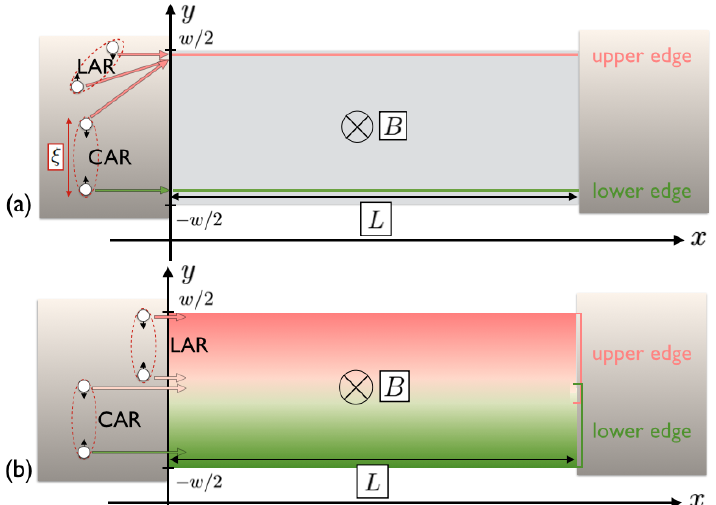
Figure 1. Panel ( a ) shows a two-dimensional topological insulator (2DTI) of length L and width w laterally tunnel-coupled to two superconducting electrodes (in grey). Then, a magnetic field B is applied perpendicularly to the junction. The pink and green line represent the edge states on the boundaries of the 2DTI which are not proximitized. Each boundary hosts two counter-propagating channels with identical profiles. For clarity, only one colored shape per boundary is shown. The electrons forming a Cooper pair (CP) can be injected into a same edge via a local Andreev reflection (LAR) or into opposite edges via a crossed Andreev reflection (CAR). The CP splitting of the latter is allowed only if the superconducting coherence length ξ , which is effectively the size of the CP, is larger or comparable with the width w . Panel ( b ) shows the same sample for the case of extended edge states, which allows different trajectories for electrons injected in LAR and a wider range of possibilities for CAR. For clarity, both panels show LAR processes involving only the upper